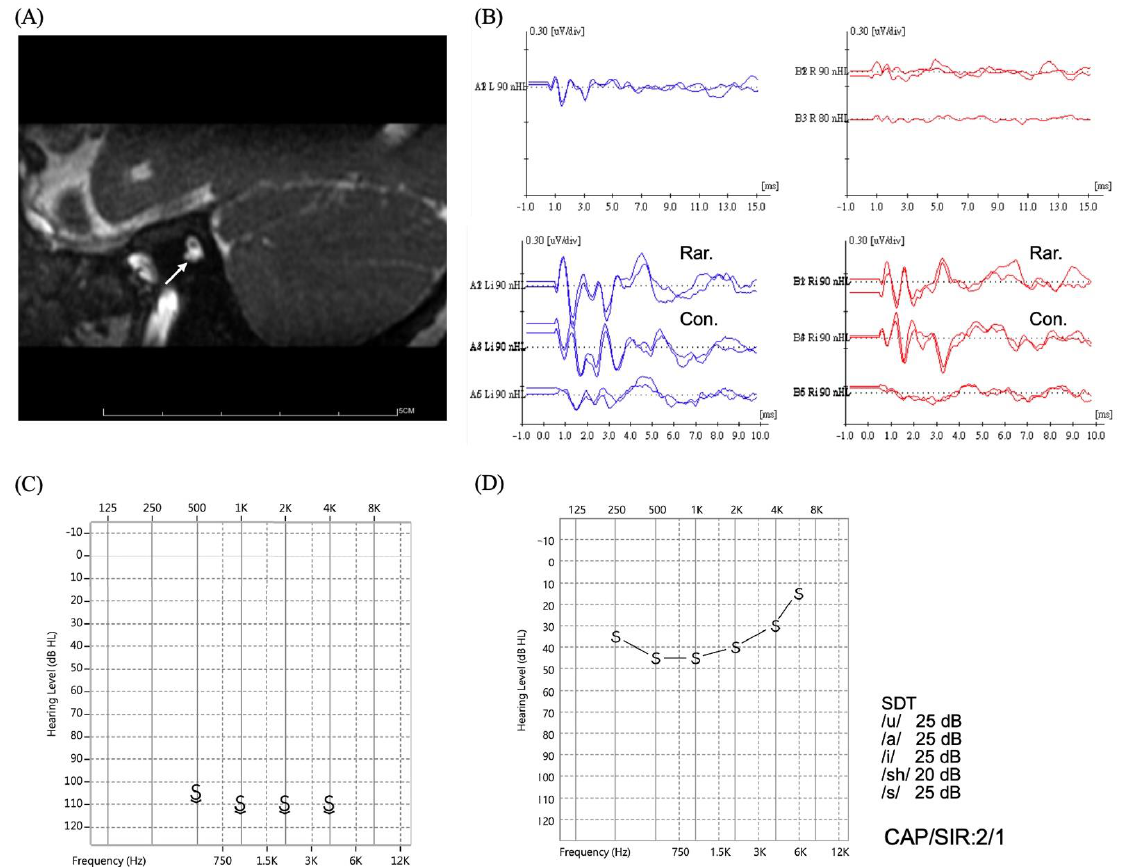
Figure 4. Cochlear implantation outcome in a patient with hypoplastic cochlear nerve. ( A ) Oblique sagittal view of the T2-weighted images on magnetic resonance imaging reveals hypoplastic cochlear nerve (arrow). ( B ) Auditory brainstem responses show no obvious wave V at 90 dBnHL, but cochlear microphonics are recorded. ( C ) The preoperative behavioral thresholds show profound hearing loss (~110 dBHL). ( D ) Poor speech performance after implantation with CAP = 2 and SIR = 1 despite elevated aided hearing threshold (~40 dBHL). Abbreviations: CAP, Categories of Auditory Performance; Con, condensation; Rar, rarefaction; SDT, speech detection threshold; SIR, Speech Intelligibility Rating.